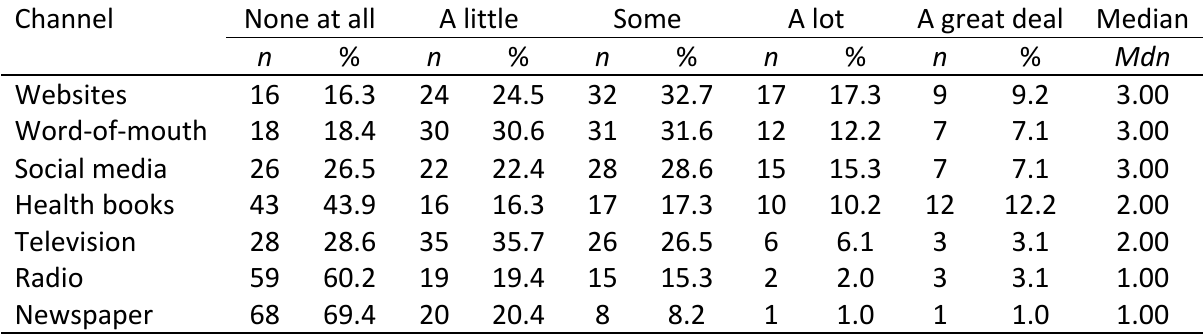
Information Channel Use Among Respondents with Negative-Leaning Perceptions of GMO